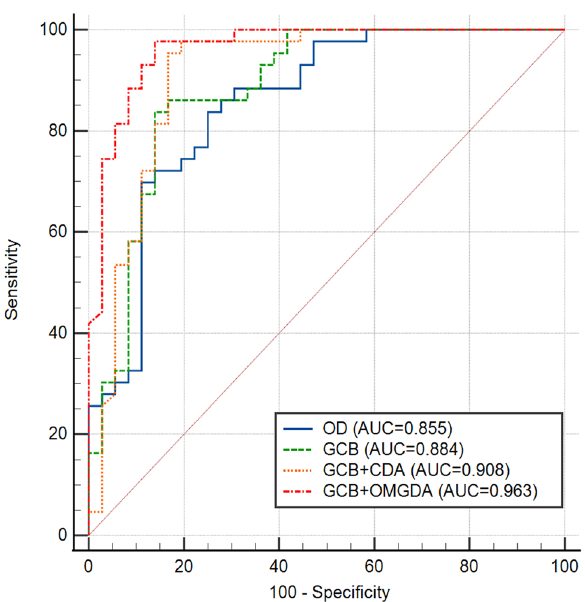
Figure 2. Receiver operating characteristic (ROC) curve analysis of four experimental models using the internal test set. (GCB: GAN-based class balancing; CDA: conventional data augmentation; OMGDA: optimal multiple of GAN-based data